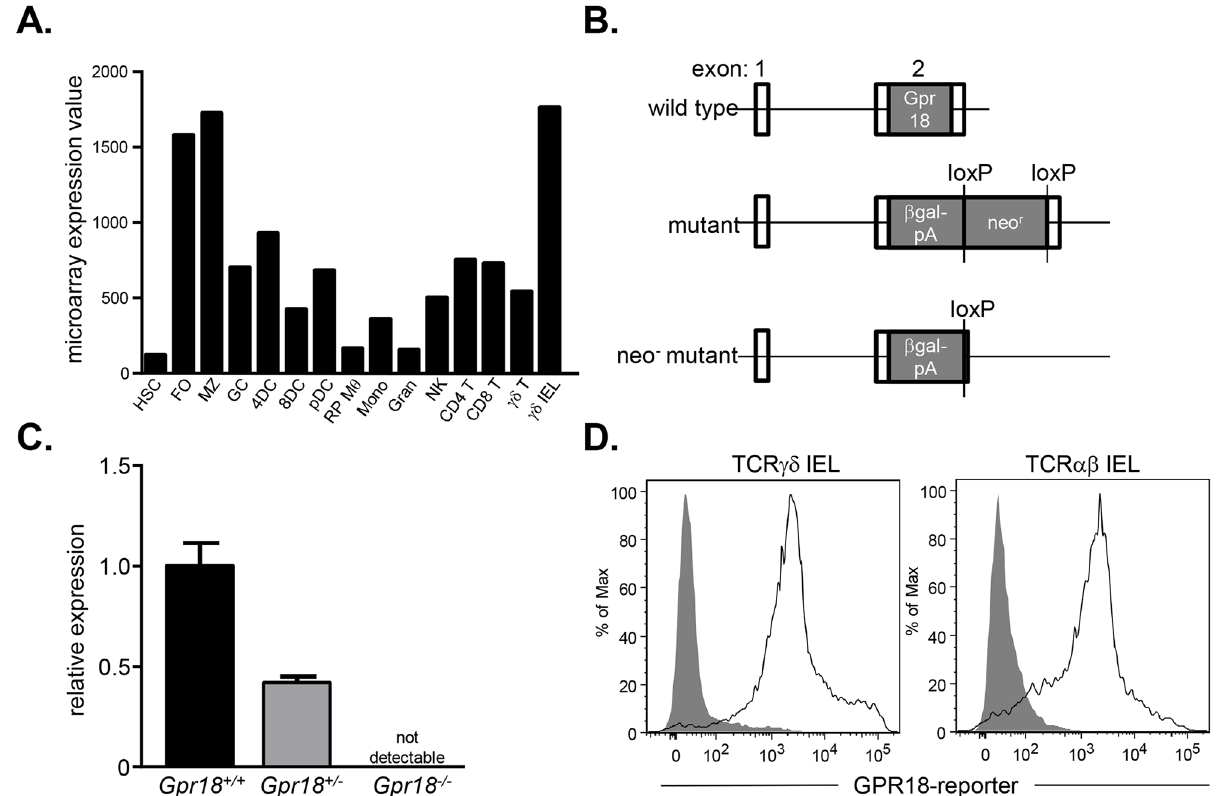
Fig 1. GPR18 is highly expressed by intestinal IELs. (A) Microarray expression data obtained from the Immunological Genome Project. (B) Targeting strategy for Gpr18 -deficient alleles. For reporter assays, the neomycin cassette was deleted by crossing Gpr18 +/- mice to a CMV-Cre-expressing strain. (C) Quantitative RT-PCR analysis of GPR18 expression in Gpr18 +/+ (black bar), Gpr18 +/- (gray bar), and Gpr18 -/- splenocytes (not detectable, so not visible on graph). Reactions were performed in technical triplicates and data are normalized to β -actin expression. Mean values ± SEM are shown. (D) Flow cytometry analysis of GPR18 expression through β -galactosidase expression in small intestine TCR γδ + and TCR αβ + IELs. Gating strategies are shown in S1 Fig. Cells from heterozygous Gpr18 +/- CMV-Cre + (solid lines) and control Gpr18 +/+ (filled histogram) mice were stained with the β -galactosidase substrate fluorescein di- β -galactopyranoside. HSC, hematopoietic stem cell; FO, follicular B cell; MZ, marginal zone B cell; GC, germinal center B cell; 4DC, CD4 + splenic dendritic cell; 8DC, CD8 + splenic dendritic cell; pDC, plasmacytoid dendritic cell; RP M θ , red pulp macrophage; Mono, bone marrow Ly6c - monocyte; Gran, bone marrow granulocyte; NK, splenic natural killer cell; CD4 T, CD4 + T cell; CD8 T, CD8 + T cell, γδ T, splenic TCR γδ T cell; γδ IEL, TCR γδ + intestinal IEL.